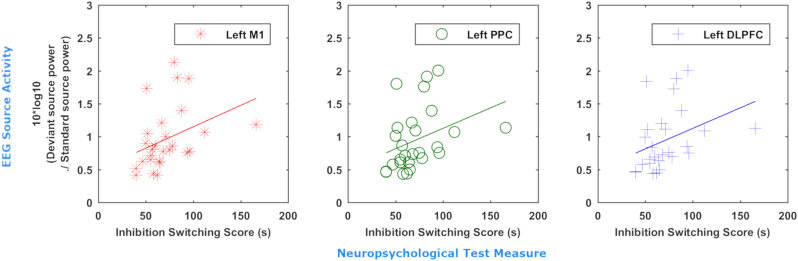
Increased activity in the posterior parietal and dorsolateral prefrontal cortex correlates to poorer performance in cognitive switching tasks. Correlation of inhibition/switching score (in seconds) for 27 patients with mean power in the left primary motor cortex (red), posterior parietal cortex (PPC, green), and middle and superior frontal gyri (M/SFG, blue) illustrated by scatterplot with line of best fit.